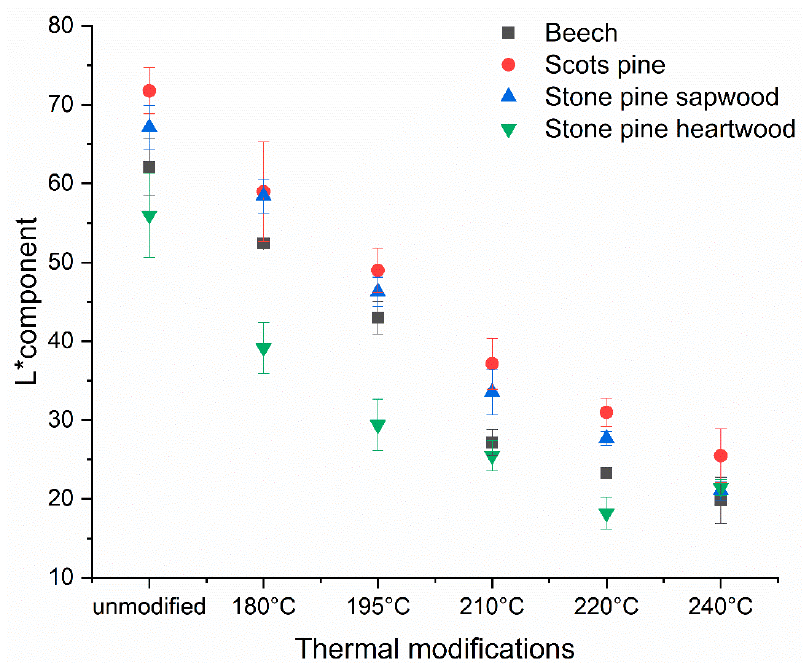
Figure 2. Thermally modified samples: Scots pine ( A ), beech ( B ), stone pine sapwood ( C ), stone pine heartwood ( D ).